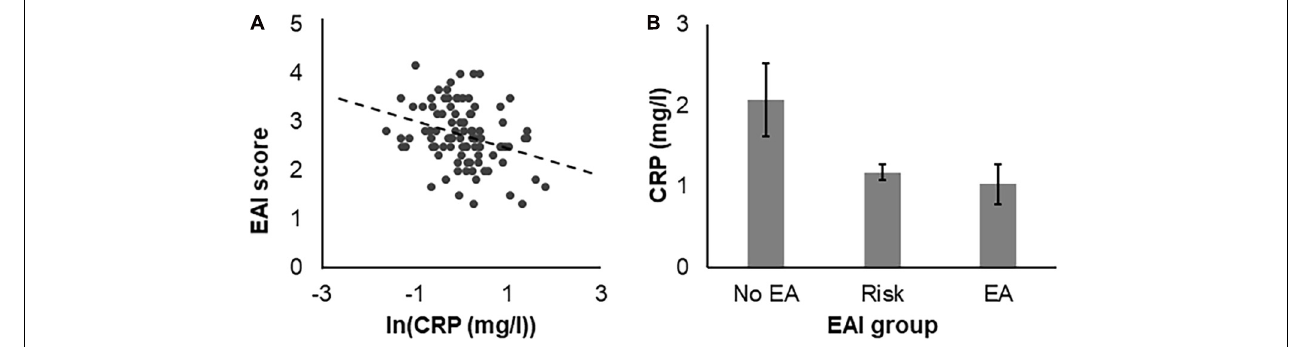
FIGURE 1 | (A) Association between C-reactive protein (CRP) levels and exercise addiction (EA) that was assessed by means of the Exercise Addiction Inventory (EAI). (B) Mean CRP levels for the three EA groups No EA ( N = 14), Risk for EA ( N = 77), and EA ( N = 4).